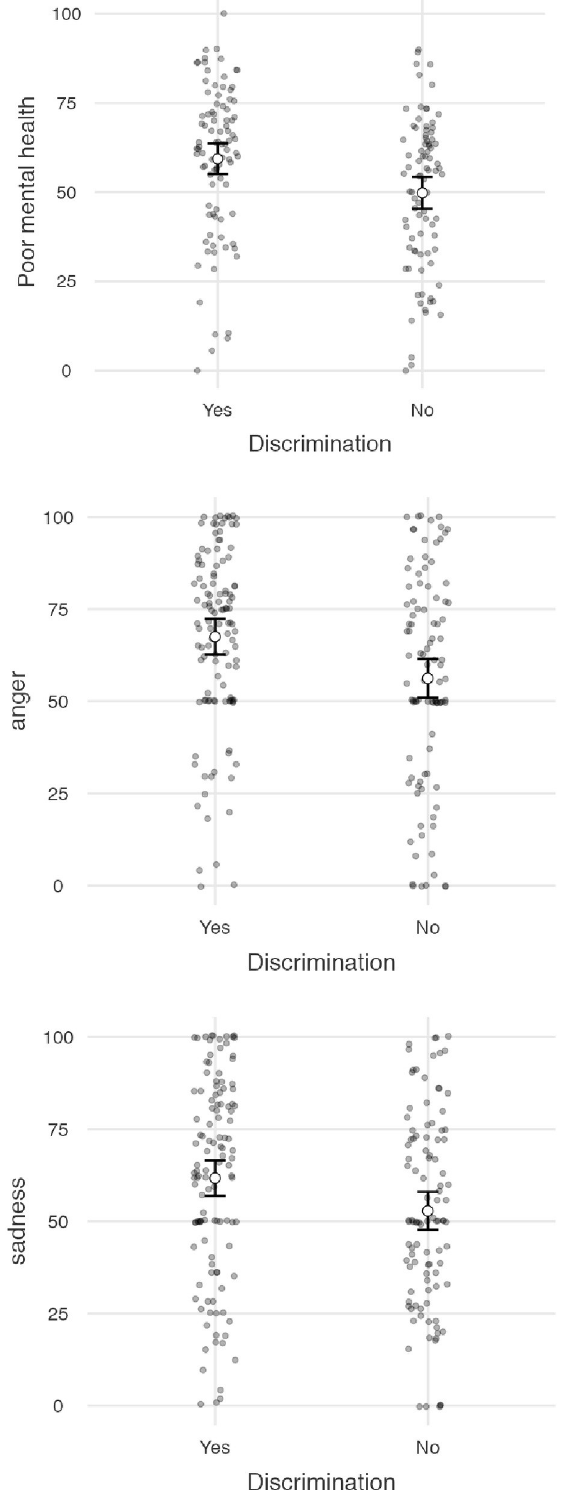
Fig 2. Marginal mean estimates (and confident intervals) for both mental health and emotional responses, within both no- and discrimination groups.